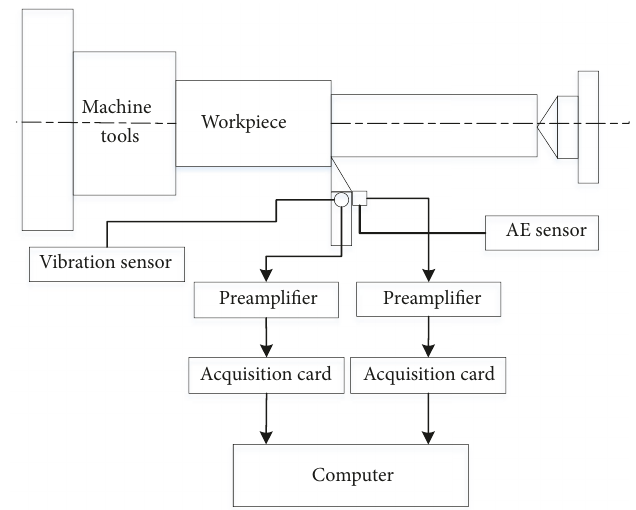
Figure 6: The flow chart of the signal acquisition.